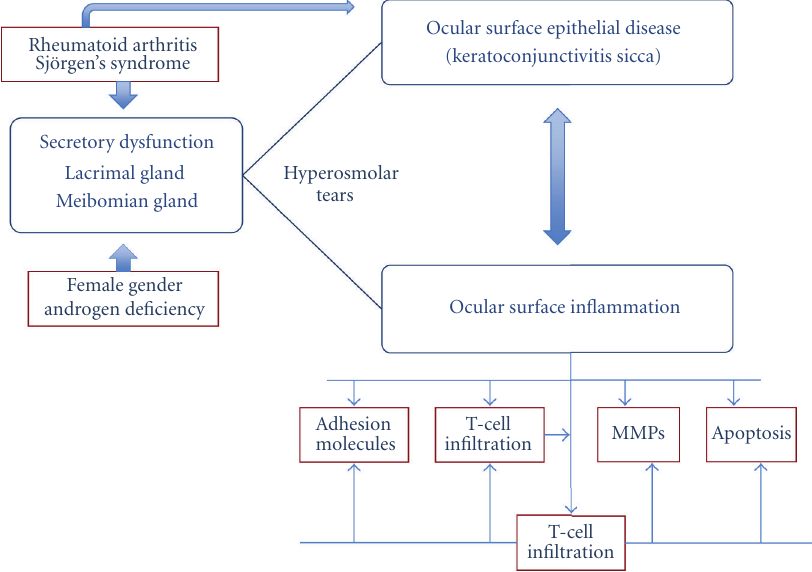
Figure 1: Inflammatory mediators in DES. (MMPs: matrix metalloproteinases) [5].